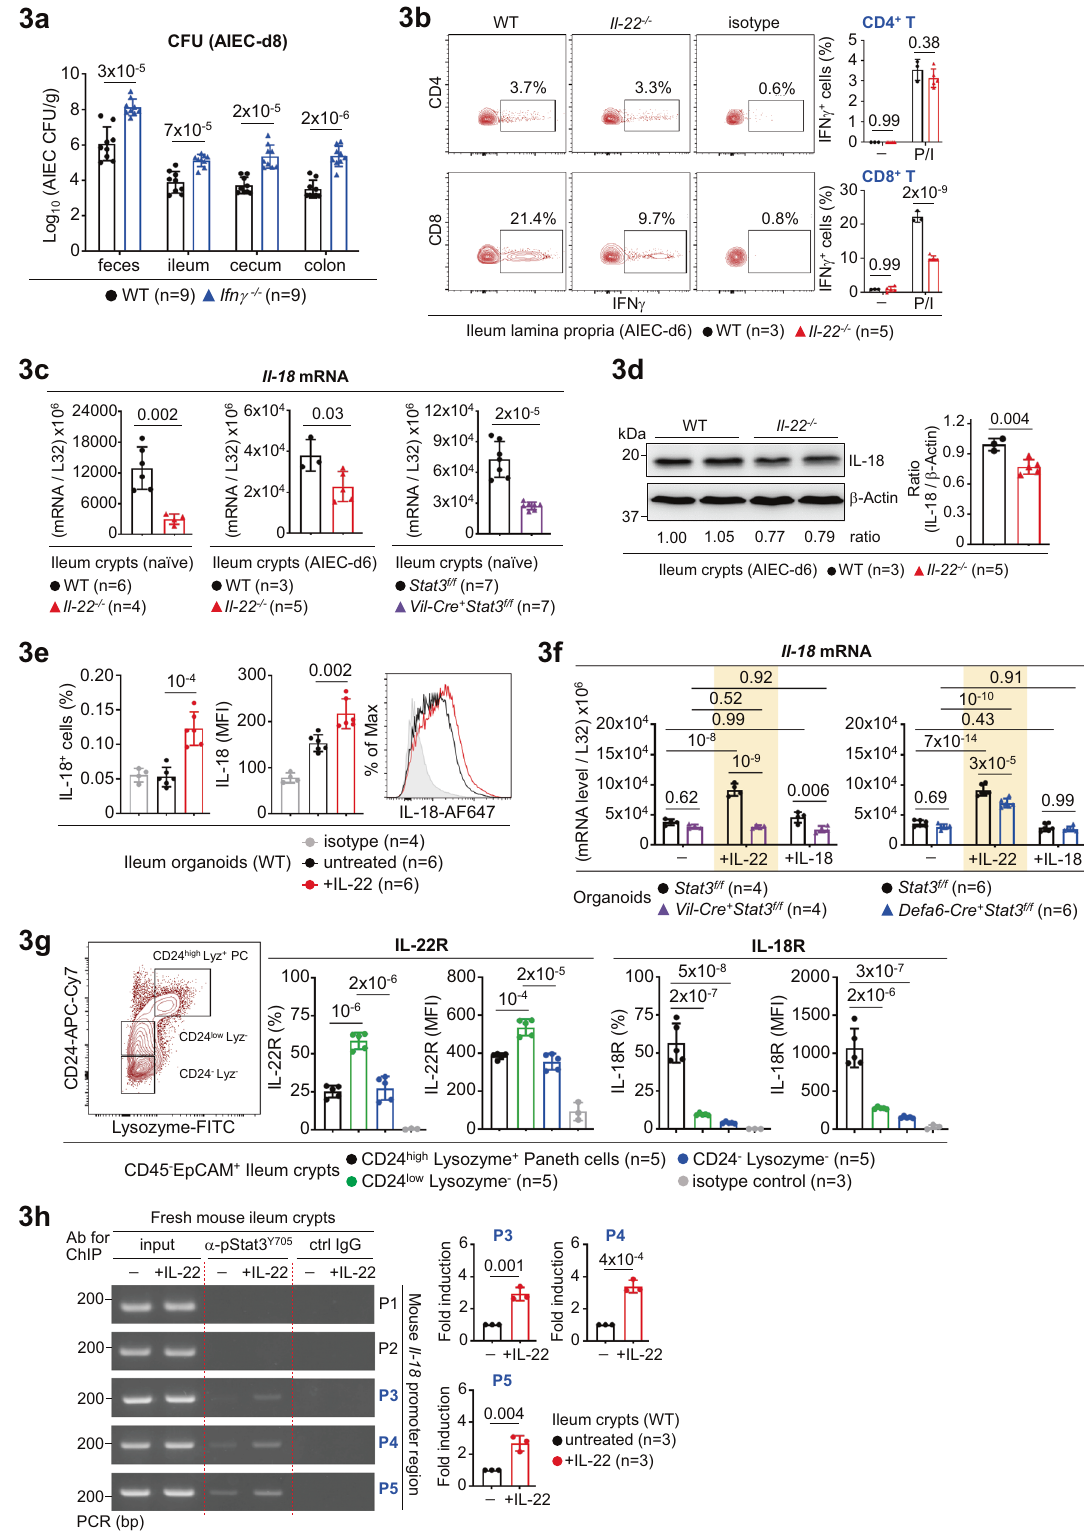
for the differentiation of epithelial secretory precursor. By immuno fl uorescence, fl ow cytometry, H&E staining, and quan- titative PCR analyses, Lysozyme-expressing and granule- containing Paneth cells were signi fi cantly reduced in Il-18 − /